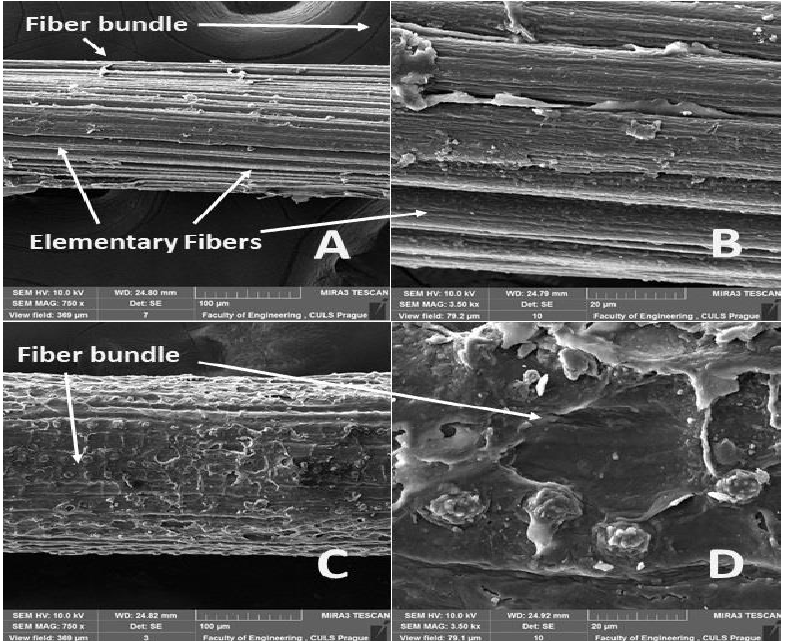
Figure 7. SEM images of the surfaces of abaca and coir fibers with treatment in a 5% solution of NaOH for 1 h ( A ): abaca fiber bundle (MAG 750 x), ( B ): detailed view of the surface of an abaca fiber (MAG 3.50 kx), ( C ): coir bundle (MAG 750 x), ( D ): detailed view of the surface of a coir fiber (MAG 3.50 kx).